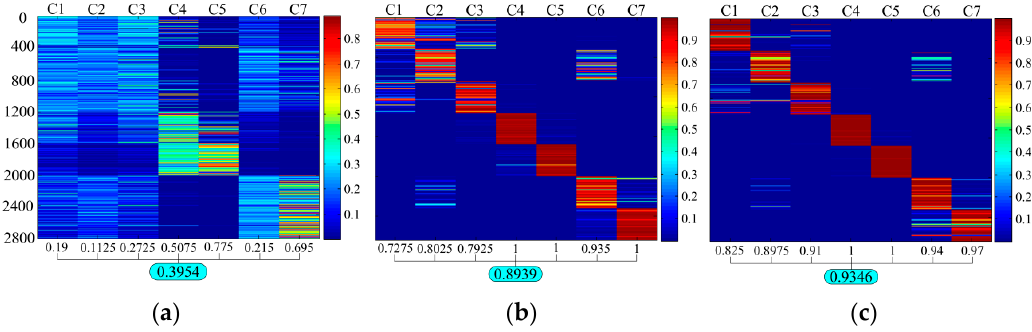
Figure 5. Confusion matrix of the fault diagnosis results: ( a ) standard DBN, ( b ) the first RBM layer of DBN replaced by GBRBM, ( c ) the proposed method.